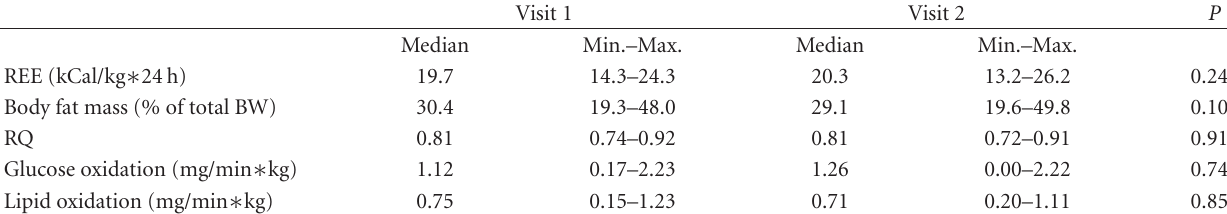
Table 3: REE, substrate oxidation, and body